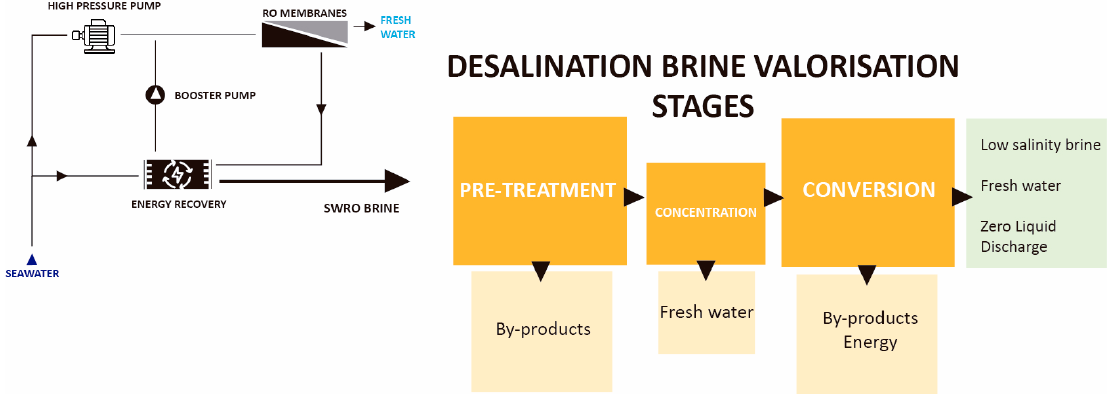
Figure 2. Brine valorisation generic fl ow diagram showing its three di ff erent stages.